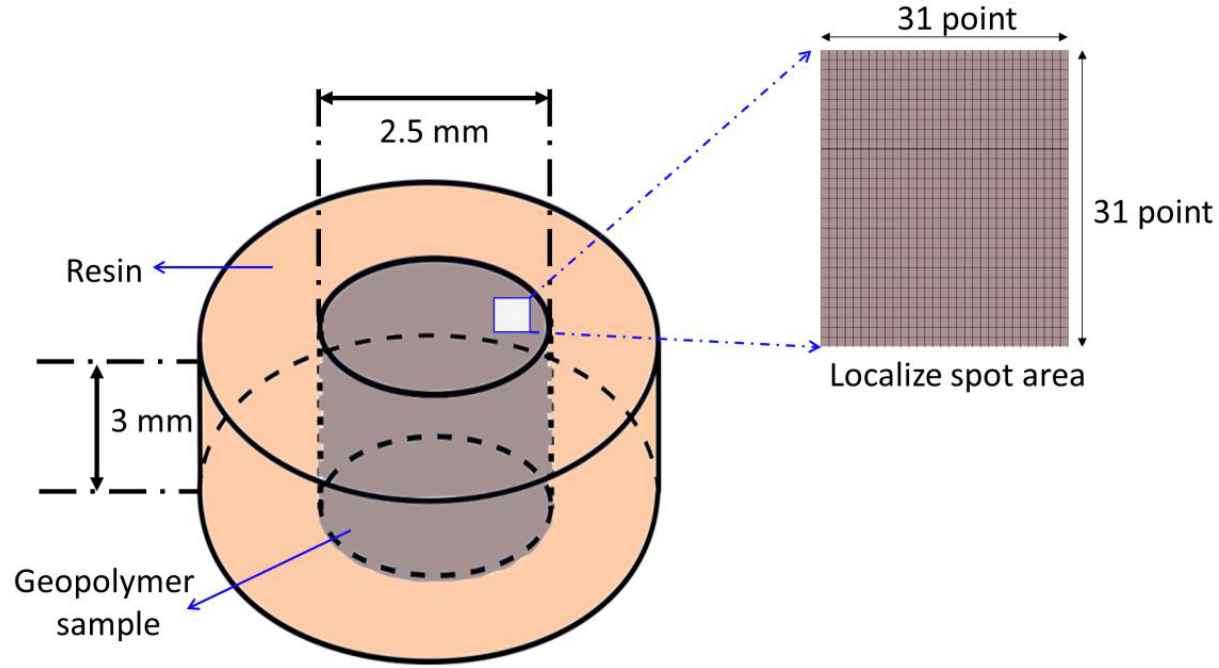
Figure 1. Specification of the sample for the synchrotron micro-X-ray fluorescence.